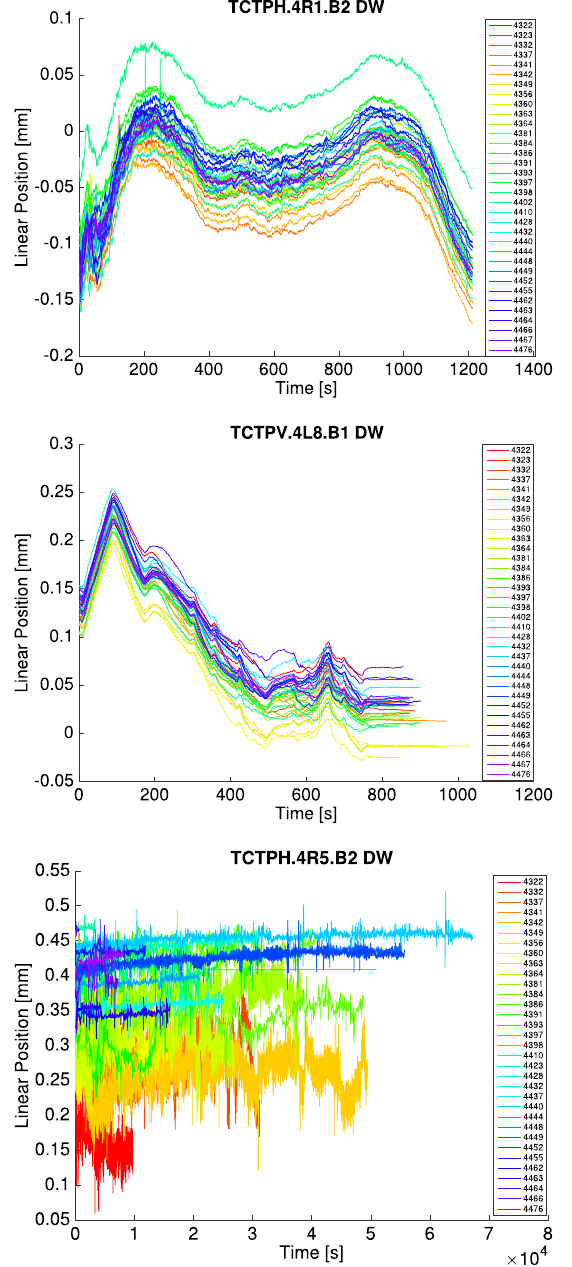
FIG. 16. Beam positions measured relative to the centers of selected collimators during the ramp (top), squeeze (center), and stable beams (bottom) in 2015, before they were used in the collimator settings generation. Each number in the legend corresponds to a separate fill for physics.